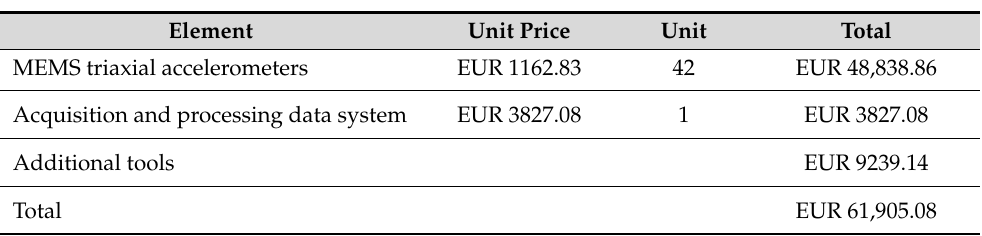
Table 12. General costs for a SHM system on Magliana bridge using MEMS accelerometers. Element Unit